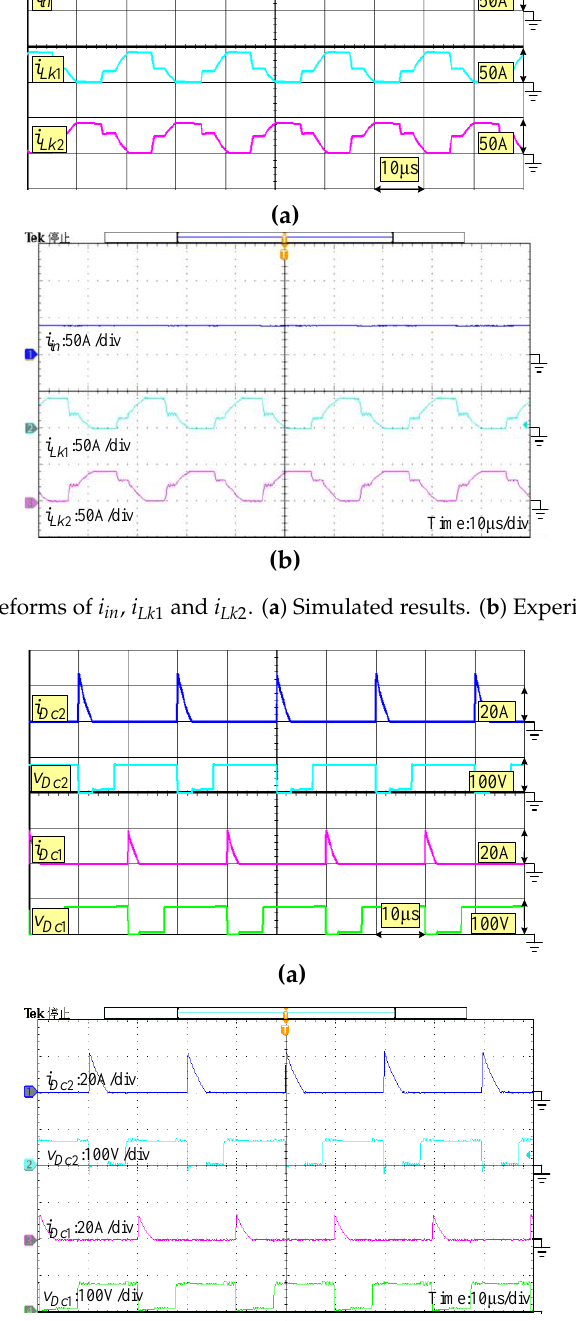
Figure 15. Waveforms of i Dc 1 , v Dc 1 , i Dc 2 and v Dc 2 . ( a ) Simulated results. ( b ) Experimental